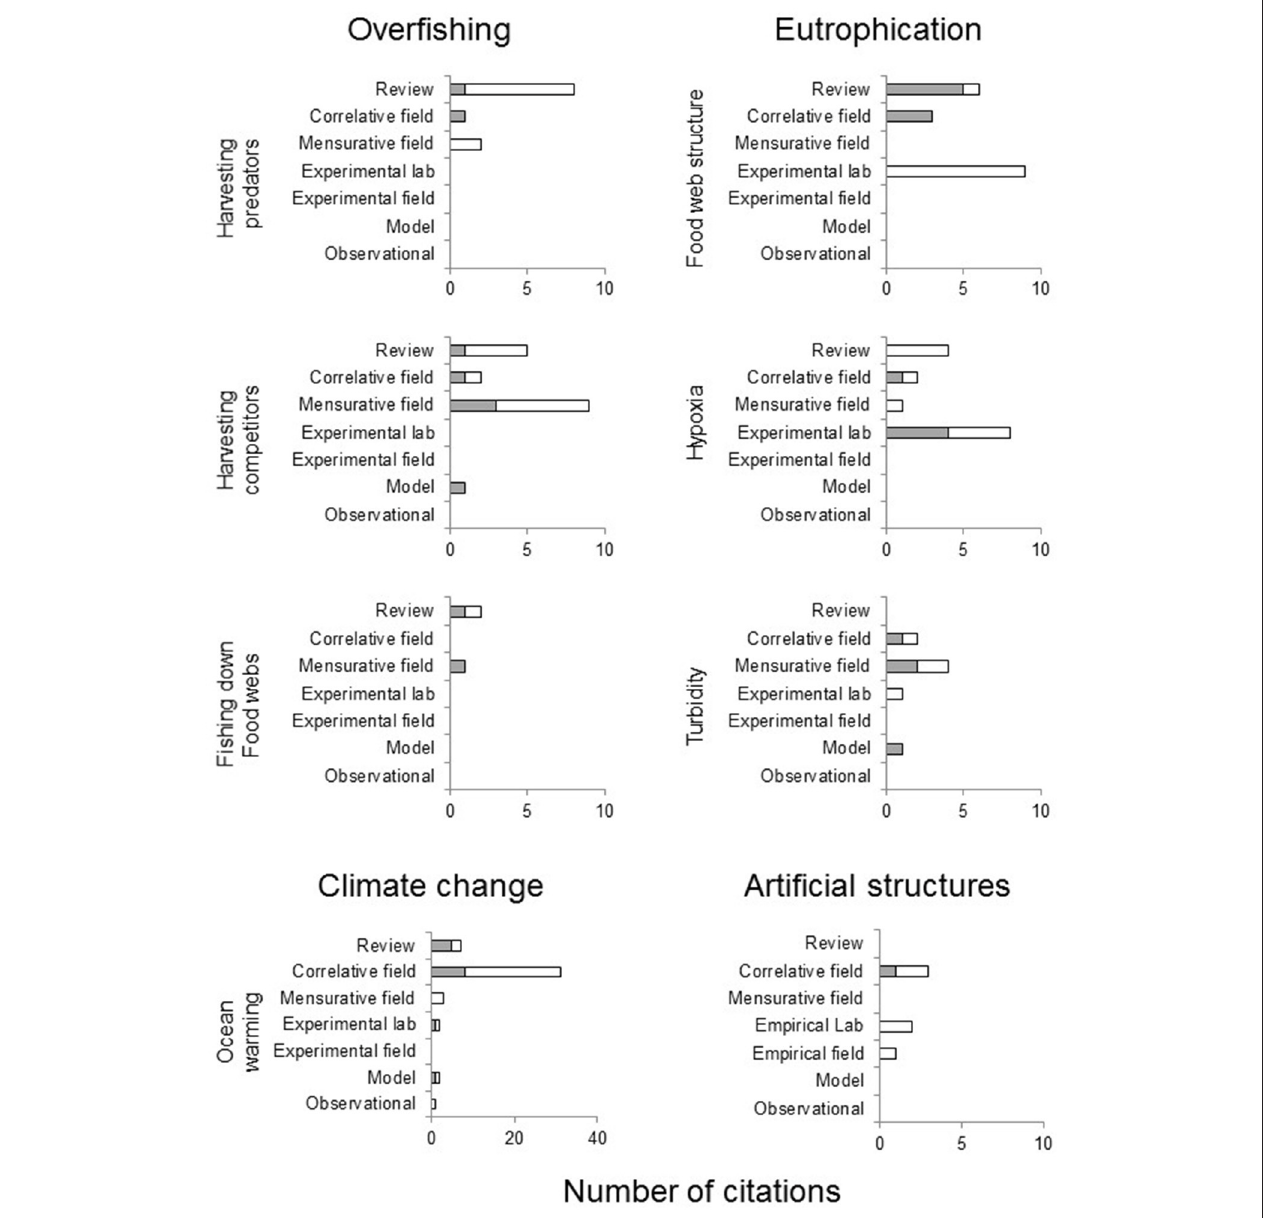
FIGURE 8 | Types of studies cited as evidence by the three most influential reviews (Purcell et al., 2007; Richardson et al., 2009; Purcell, 2012) for the anthropogenic stressors most commonly cited to cause jellyfish blooms. White, circumstantial evidence; gray, non-circumstantial